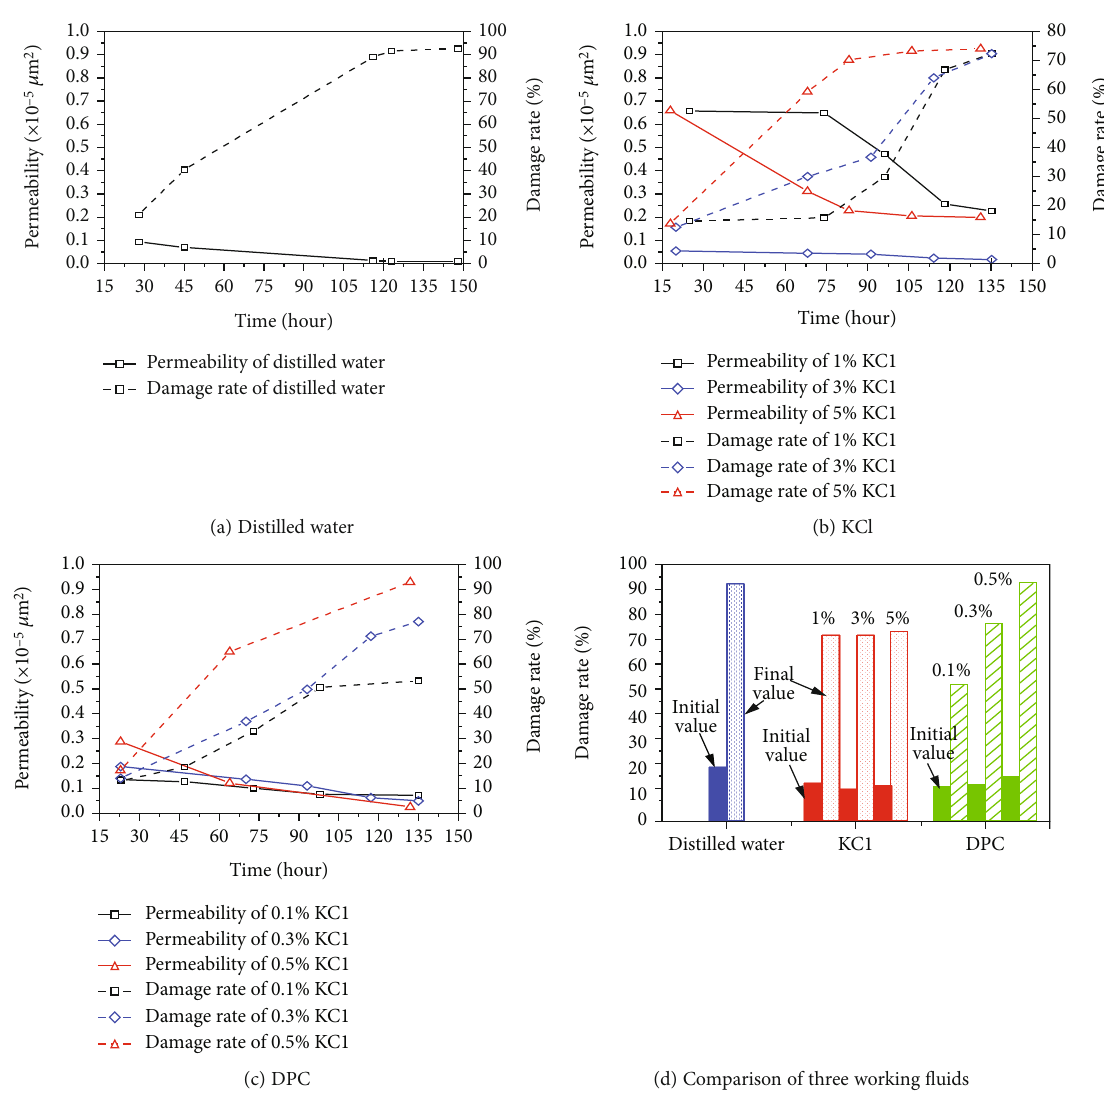
Figure 5: Evaluation of the damage of di ff erent fl uids on coal reservoir permeability.